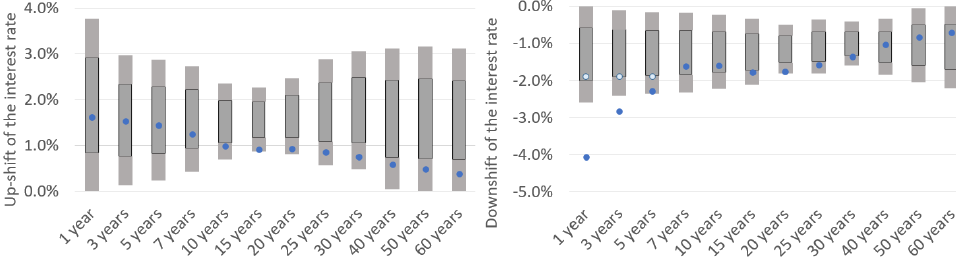
Figure 9. Comparison of the simulated shifts (left: up, right: down) for interest rate risk factors; representation based on own results (blue dots) and EIOPA (2021a, p. 22) (gray boxes). The up-shifts generated by the GAN-based model are within the boxes for all